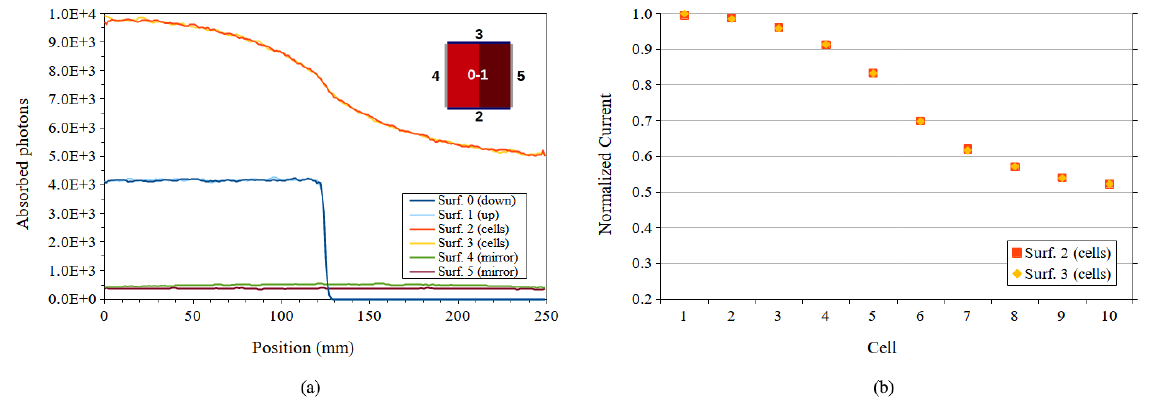
Figure 12. Shaded LSC panel with two 10-cells PV arrays, shading across the PV arrays: ( a ) Number of rays of light collected by the PV cells as a function of the position along the LSC side, which ranges from 0 mm to 250 mm. ( b ) Normalized current produced by each PV cell.